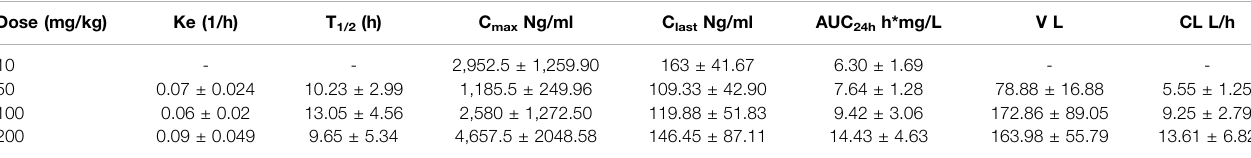
TABLE 5 | Pharmacokinetic values of 25 – 106 in the